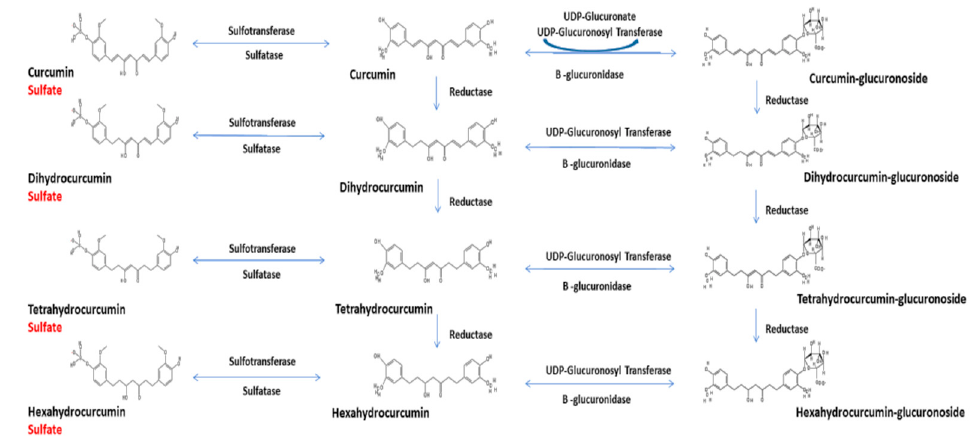
Figure 1. Metabolic pathways of curcumin.